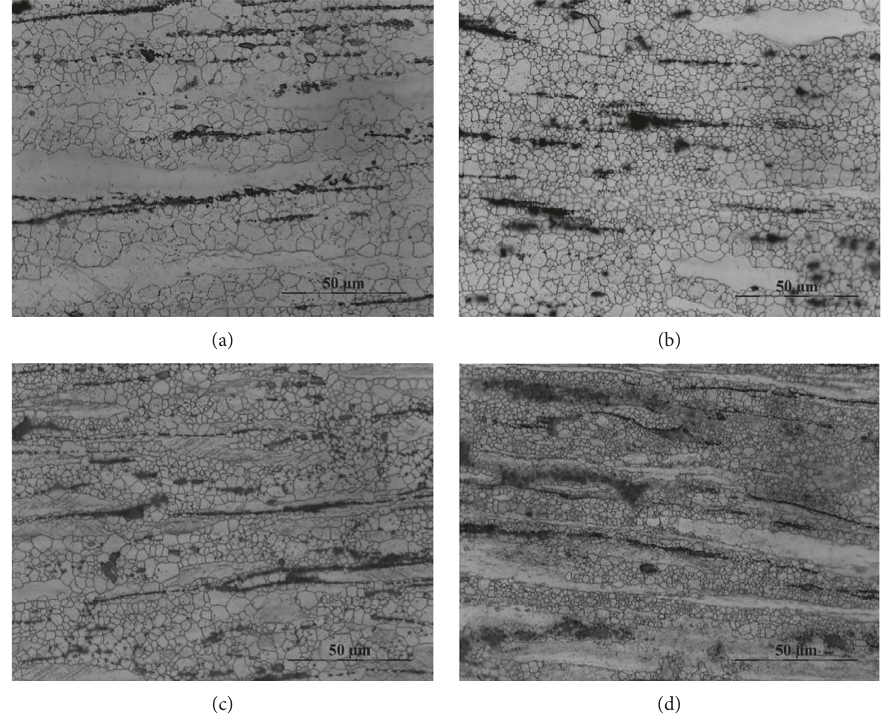
Figure 5: Optical micrographs of the as-extruded Mg-Zn-Gd(-Ca) alloy: (a) Mg-7.2Zn-2.4Gd, (b) Mg-7.2Zn-2.4Gd-0.16Ca, (c) Mg-7.2Zn- 2.4Gd-0.32Ca, and (d)